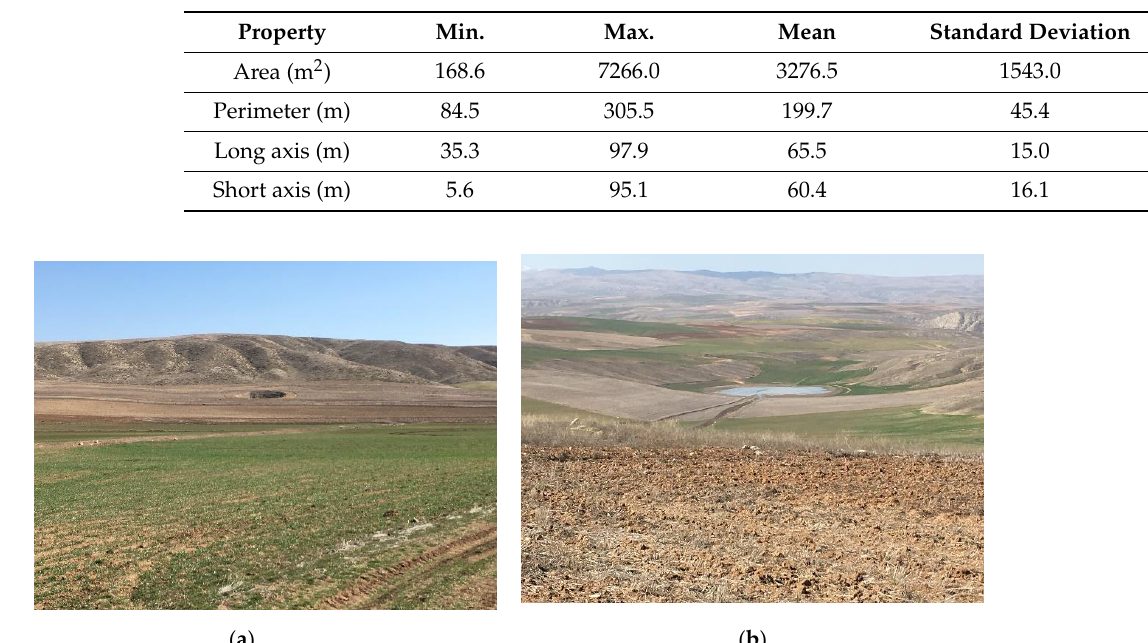
Figure 2. The general views of the Sekili evaporite member in the study area. (Photographs were taken at the location with the coordinates X=586,366 m, Y= 4,406,890 m defined in Universal Transverse Mercator (UTM) Projection Zone 36N and WGS84 Datum on 26 February 2019 by H.A.N., the first author). Table 1. Descriptive statistics of the geometric properties of the sinkholes observed in the study area.